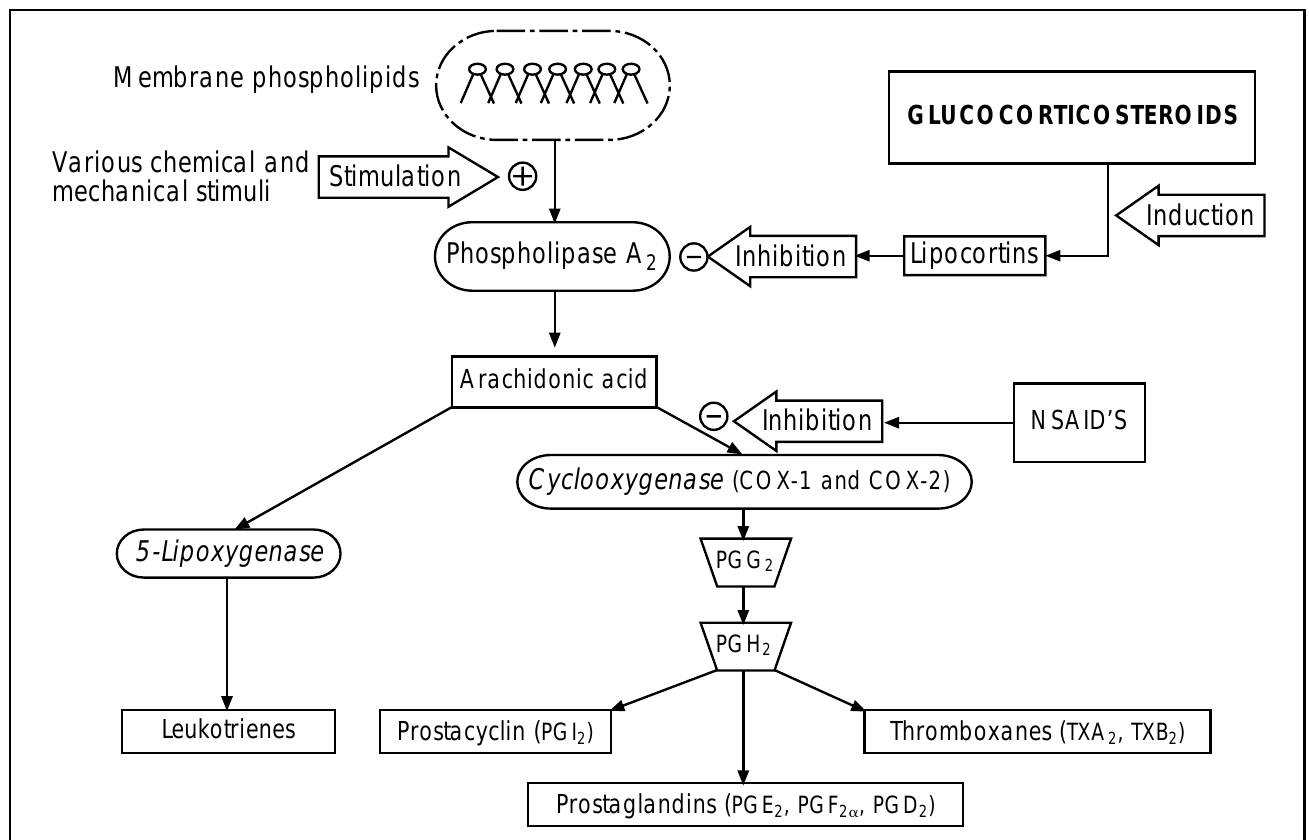
Figure 1: Mechanism of action of the